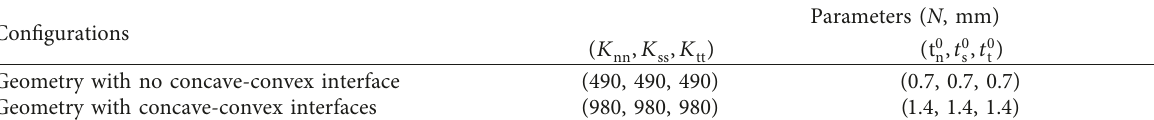
Table 10: Parameters for modeling vertical contact surfaces.